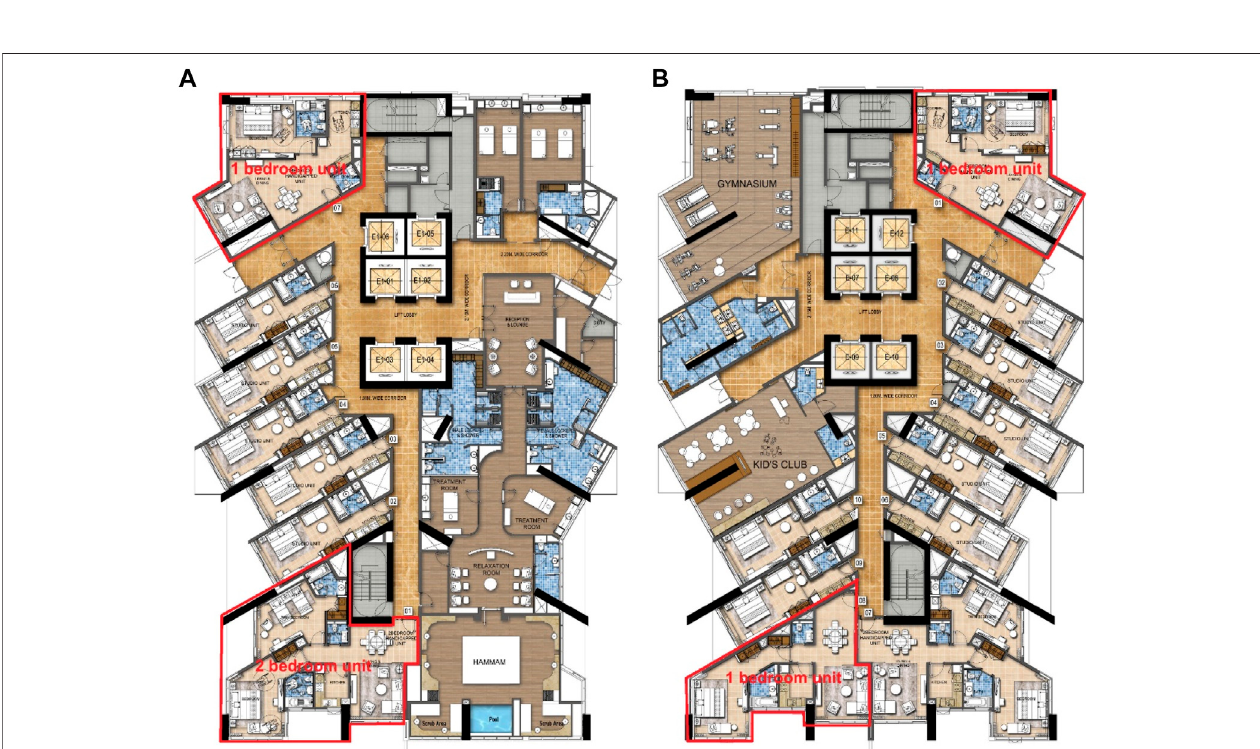
FIGURE 1 | DAMAC Maison Privé in Business Bay, Dubai.